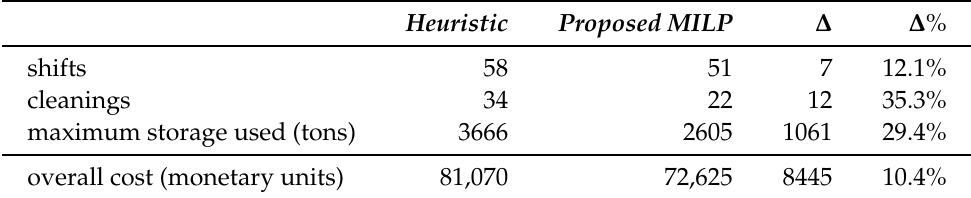
Table 7. Relevant metrics of the plans computed by the proposed MILP method and the comparison with the heuristic method considered to be a reference